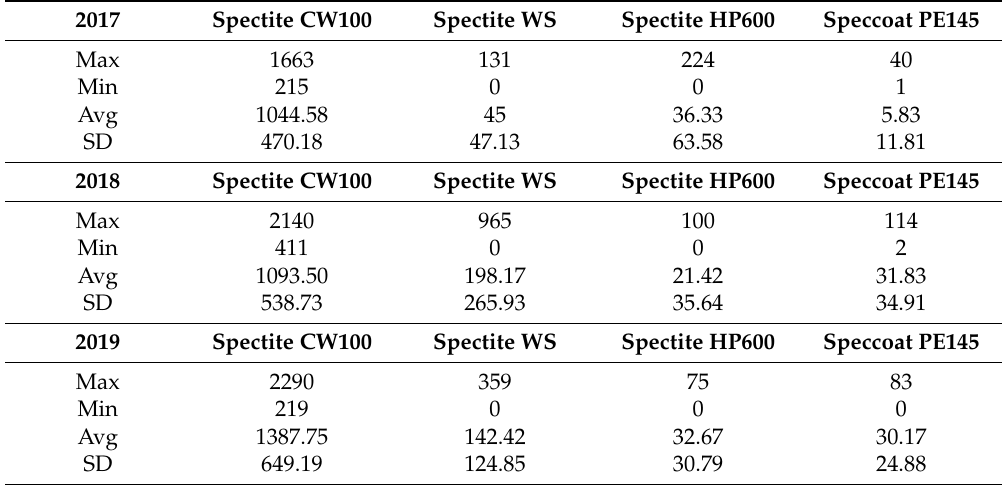
Table 2. Statistical summary of historical sale data added up to 36 months (2017–2019).